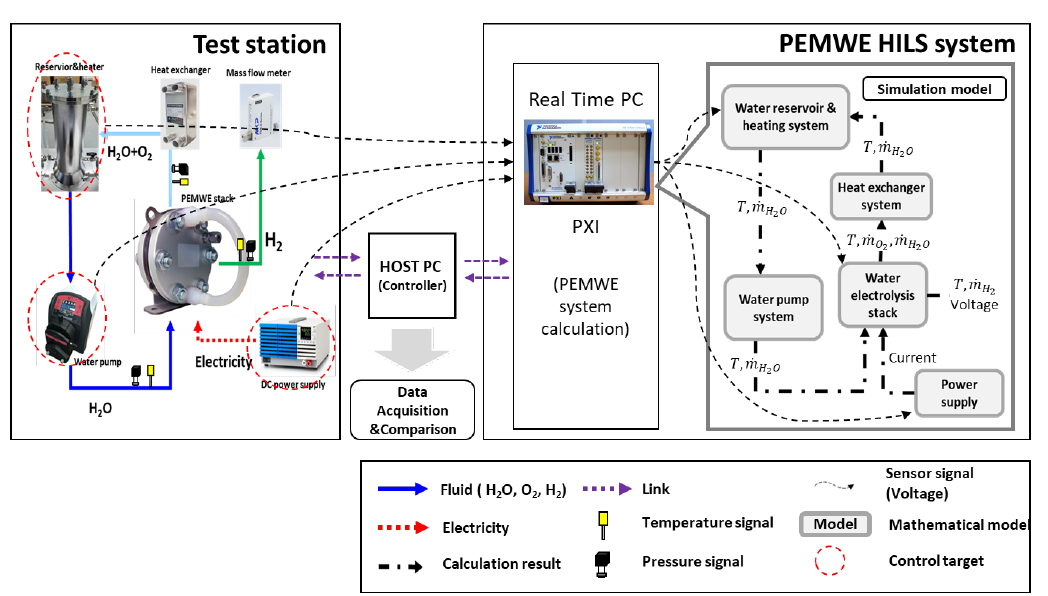
Figure 7. Signal flow chart of the PEMWE HILS system.